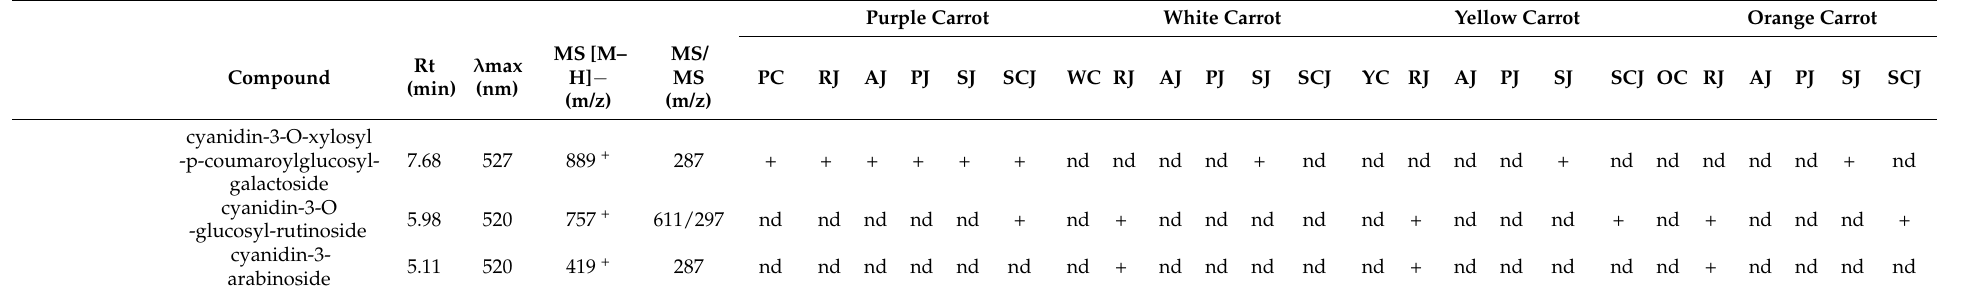
Table 3. Cont. Purple Carrot White Carrot Yellow Carrot Orange